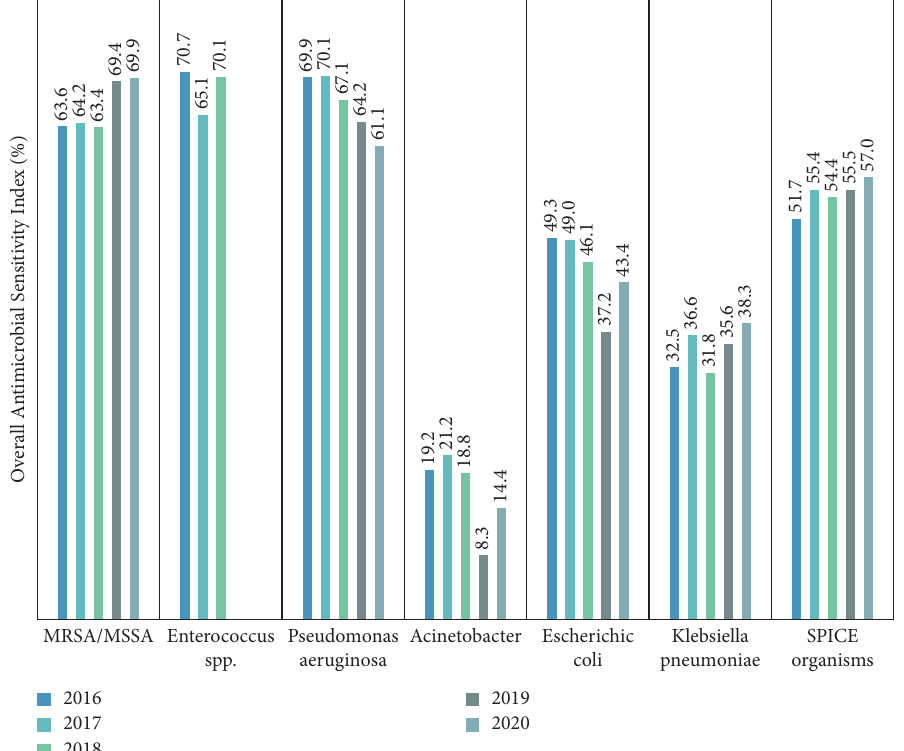
Figure 5: Overall antimicrobial sensitivity index (OASI) of different microorganisms between 2016 and 2020. OASI: overall antimicrobial sensitivity index is an estimate of the sensitivity of a microorganism to the different antimicrobials and is calculated as the average percentage of sensitive isolates in the tested antimicrobials.